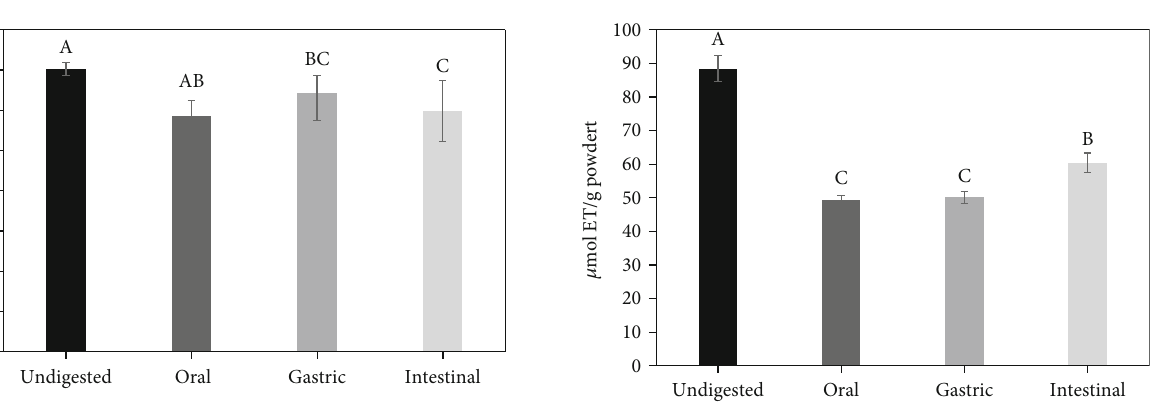
Figure 4: Antioxidant capacity of microencapsulated extracts during the in vitro digestion process.